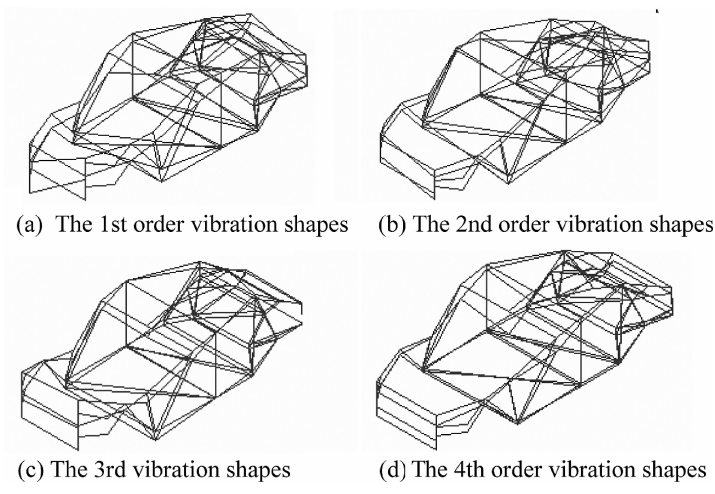
Fig. 11. The 1st-4th order vibration